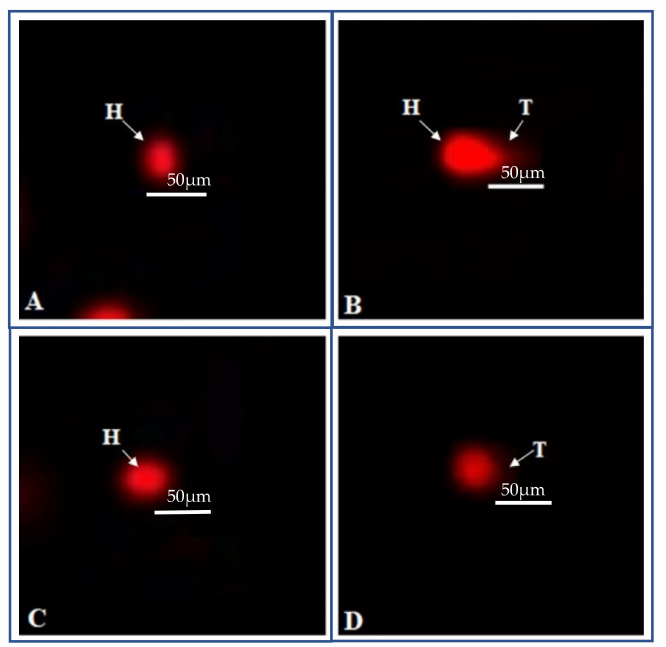
Figure 7. Genotoxicity evaluation of MVL on blood lymphocytes. “H” represents Head and “T” represents Tail. ( A ) Vehicle control (1% DMSO) ( B ) Ethyl methane sulfonate (20 µ g/mL) ( C ) MVL (10 µ g/mL) ( D ) MVL (20 µ g/mL). Table 3. Genotoxicity assessment of MVL on blood lymphocytes by comet parameters.